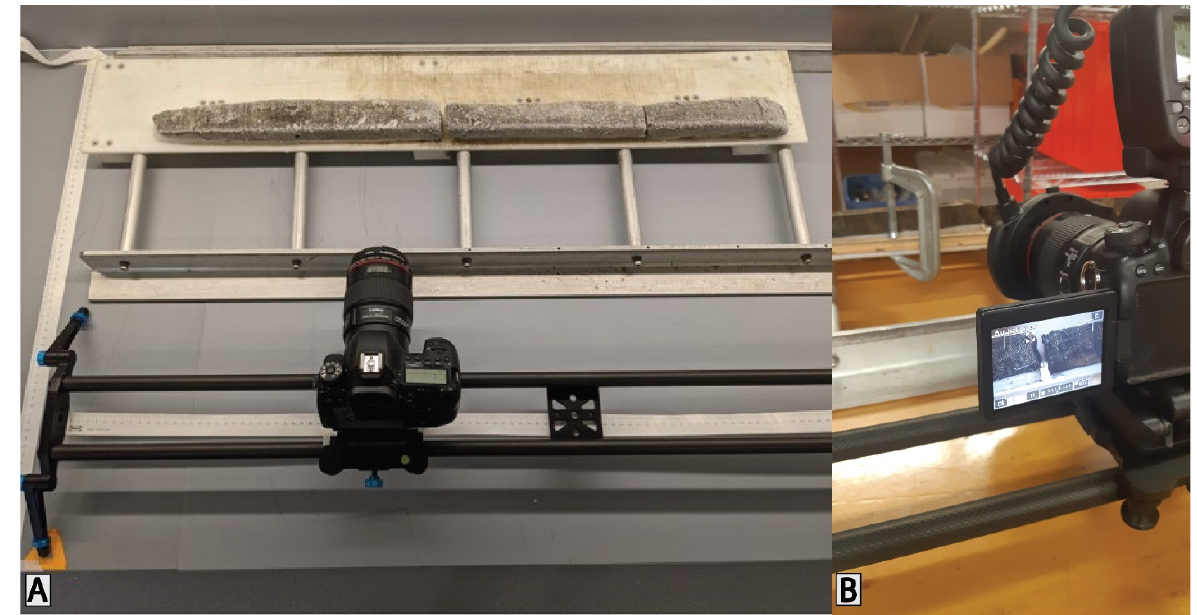
Figure 4. ( A ). Photography set up showing camera mounted on sliding rail to image a cross section of the core. ( B ). Ring light mounted on